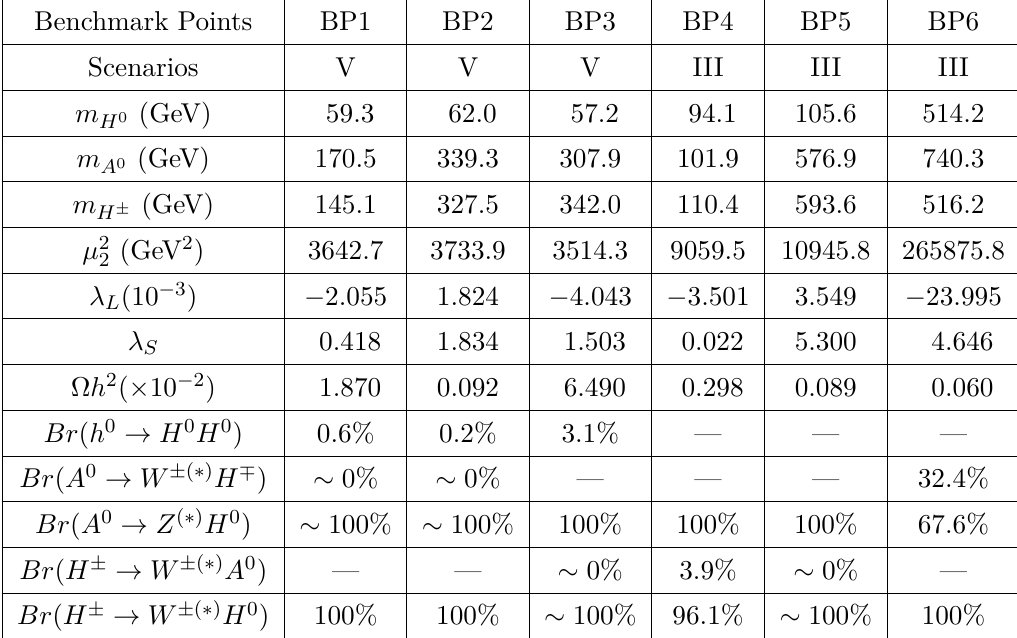
Table 4 . Benchmark points consistent with collider experiments and dark matter constraints on the relic density are proposed. Decay information of H 0 , A 0 and H ± are also